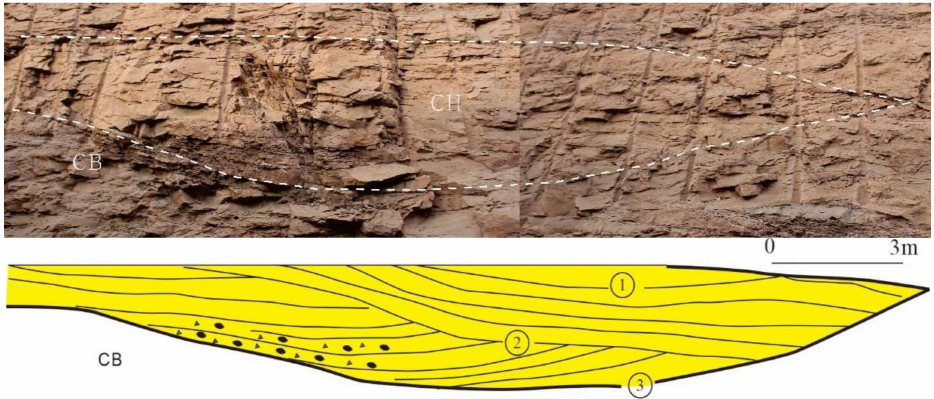
Figure 5. The typical channel architecture elements of the outcrop section of the Yungang Formation include a filling channel and unilateral accretion migration channel. 1 (cid:13) , 2 (cid:13) and 3 (cid:13) represent the shape of the river bottom in different